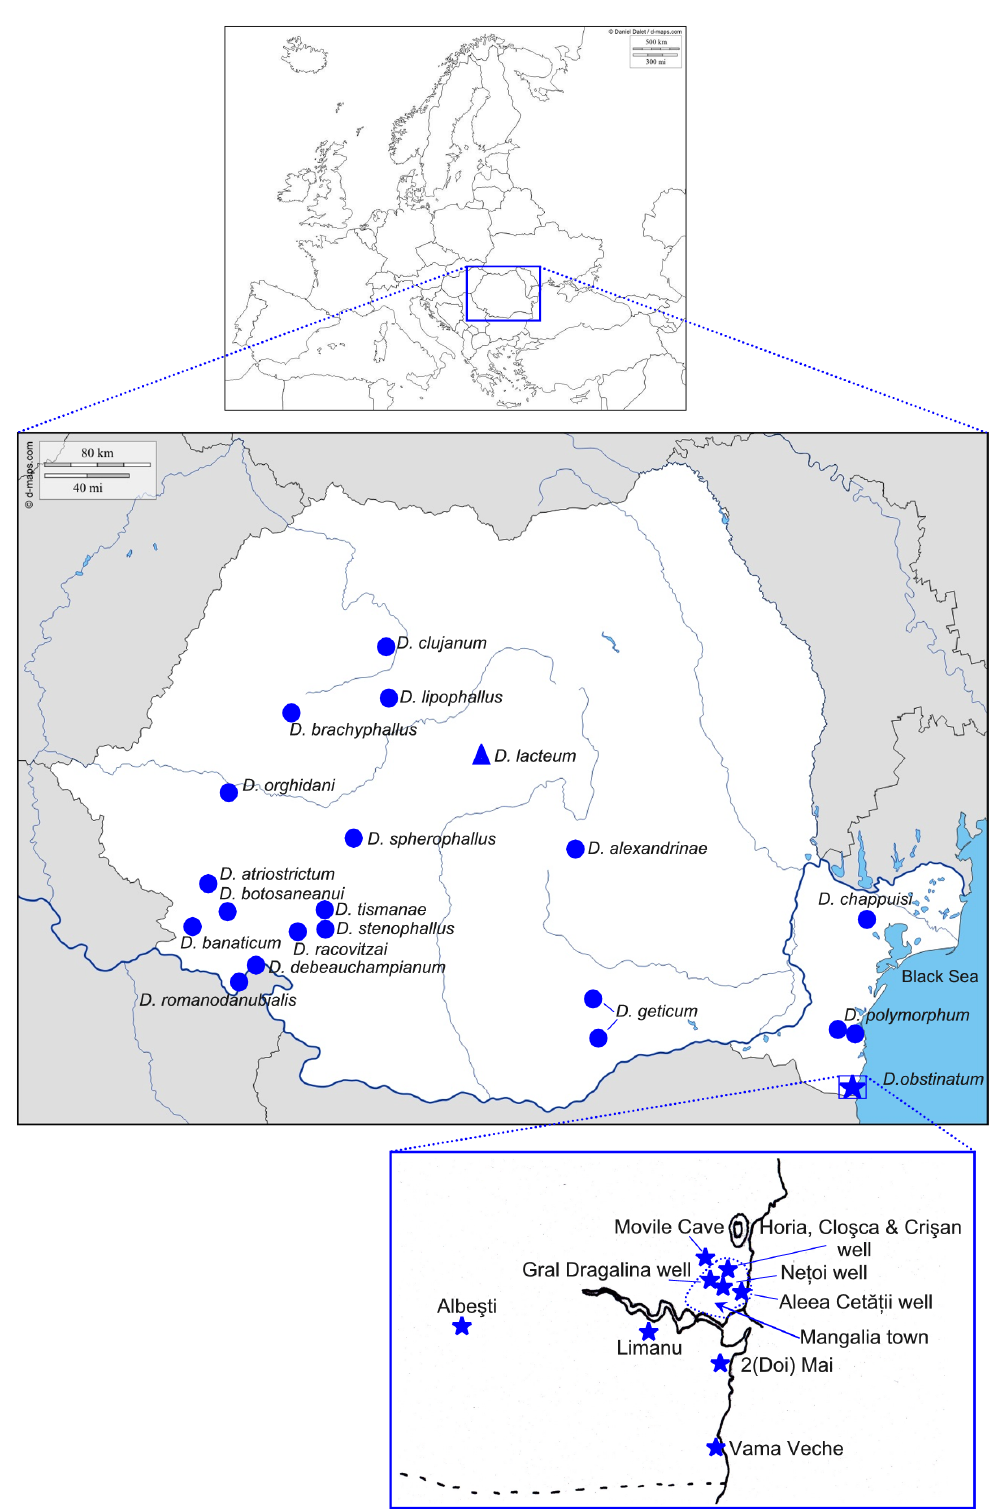
Fig. 1. Geographic distribution of freshwater planarians of the genus Dendrocoelum recorded from Romania. ▲: unspecified locality of D. lacteum Müller, 1774. Rectangular inset (bottom) corresponds with enlarged area, showing the collection sites of D. obstinatum Stocchino & Sluys, sp. nov. indicated by blue stars (see also Table